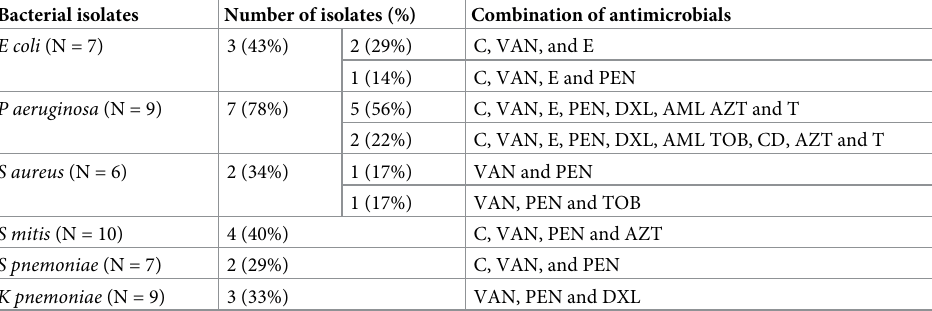
3 (33%) VAN, PEN and